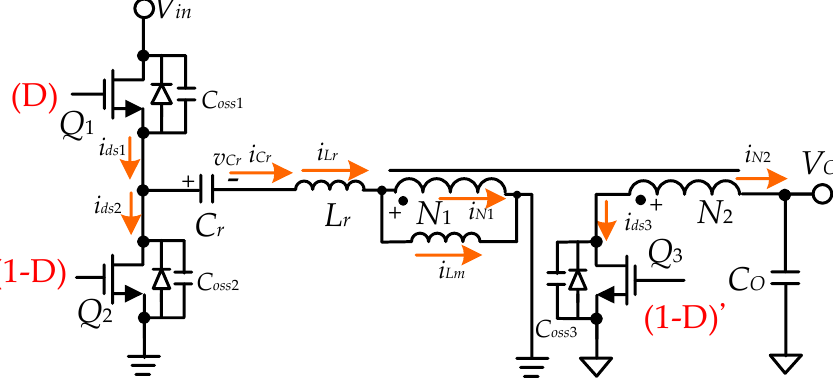
Figure 2. The proposed resonant AHB flyback converter.